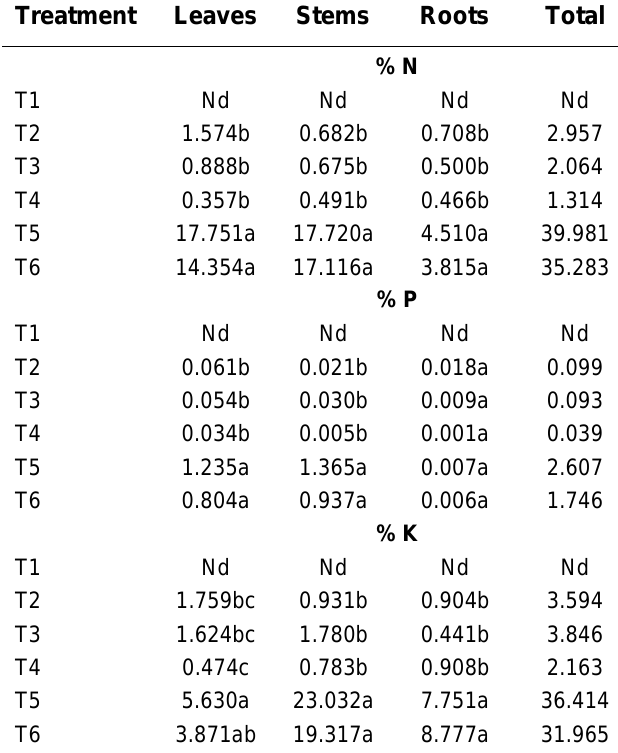
Effect of Different Treatments on N, P, and K Use Efficiency in Leaves, Stems, and Roots of Maize Plant at 57 DAS Treatment Leaves Stems Roots